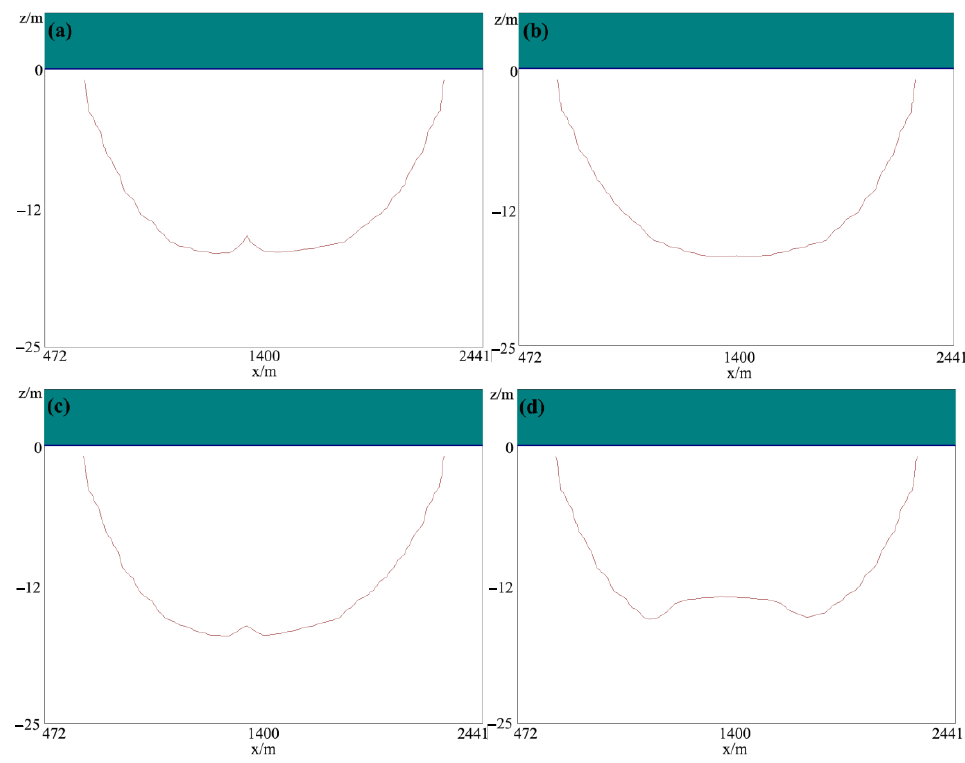
Figure 9. Sectional views of the freshwater lens: ( a ) original condition; ( b – d ) impermeable surfaces set in the southwest, northeast and middle of the island, respectively. Table 2. Volume of the freshwater lens and its reduction rate under different conditions compared to the initial